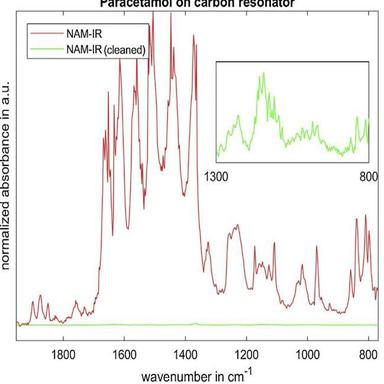
Normalized NAM-IR spectra of the pyrolytic carbon string resonator before (red) and after in situ regeneration (green) (For interpretation of the references to colour in this figure legend, the reader is referred to the web version of this article).